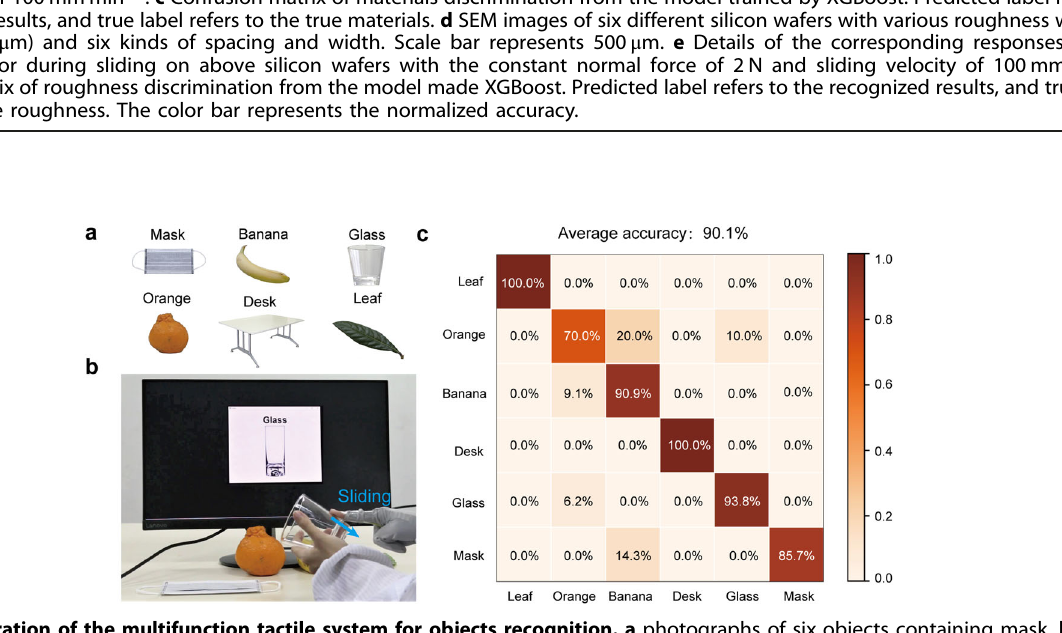
Fig. 6 Demonstration of the multifunction tactile system for objects recognition. a photographs of six objects containing mask, banana, glass, orange, desk and leaf. b The actual online recognition by dragging the bioinspired sensor on the target object and then the recognition result showed on the screen. The blue arrow identi fi ed the direction of sliding. c Confusion matrix of above six objects recognition from the model trained by XGBoost. Predicted label refers to the recognized results, and true label refers to the true objects. The color bar represents the normalized